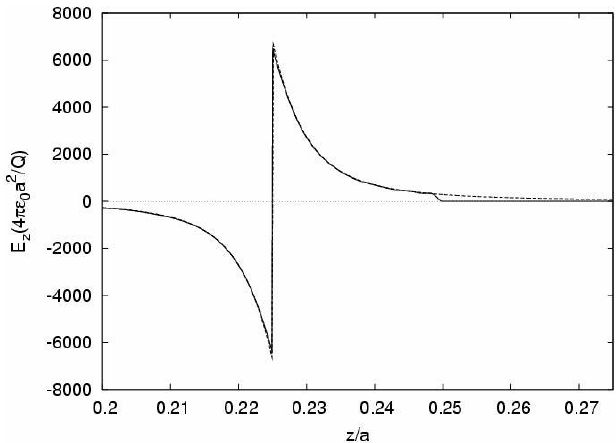
numerical scheme (solid line) and the benchmark example (dashed line).